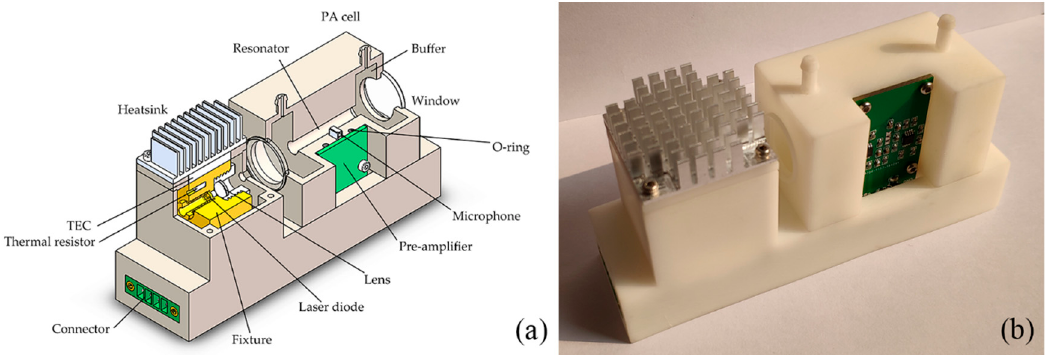
Figure 3. ( a ) A 3D model of the assembled sensor; ( b ) the entity. The dimension is 120 mm × 65 mm × 35 mm.